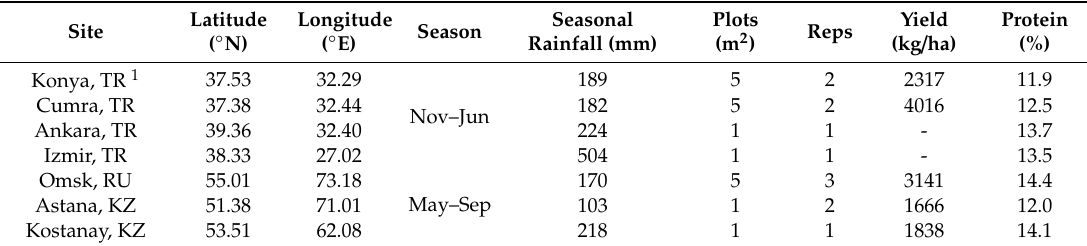
Table 2. Characteristics of the experimental sites used in